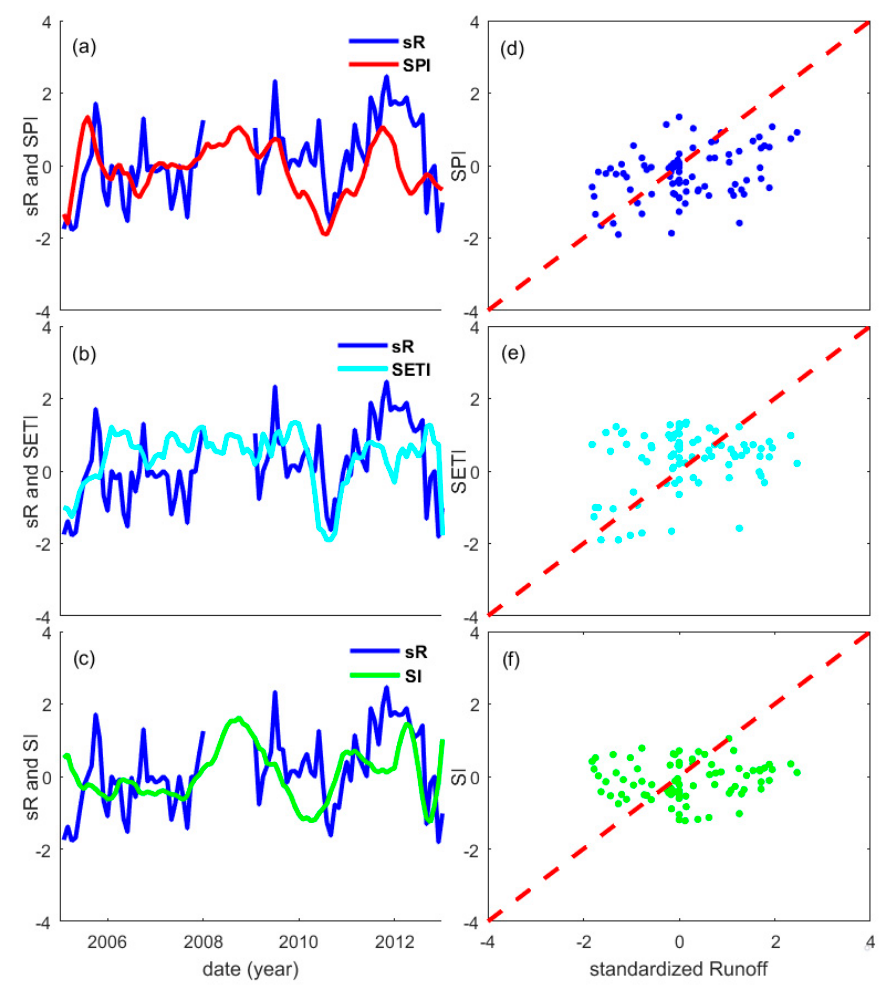
Figure 7. Runo ff time series in the standardized form plotted against the standardized, remotely-sensed hydrological variables (RSHVs) at Tan Chau station: ( a , d ) SPI, ( b , e ) SETI, and ( c , f ) SI values. The two columns represent the time series of (left) the standardized runo ff and the standardized RSHV and (right) their scatter plots.